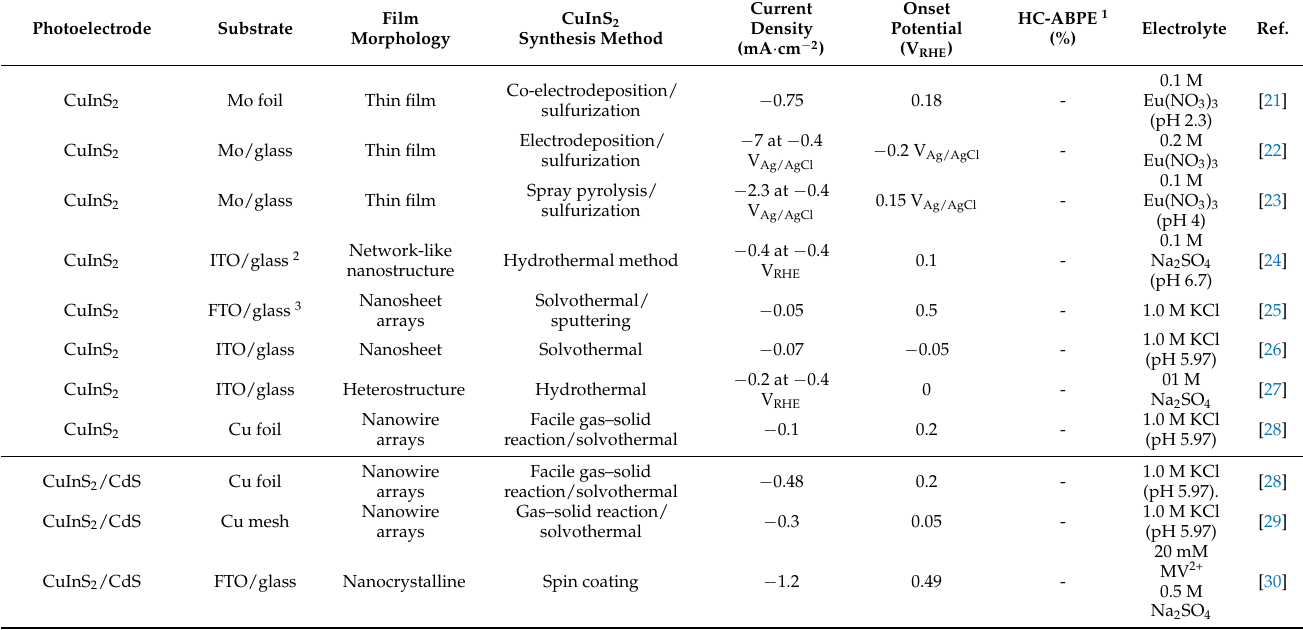
Table 1. Activity of CuInS 2 -based photocathodes for PEC hydrogen